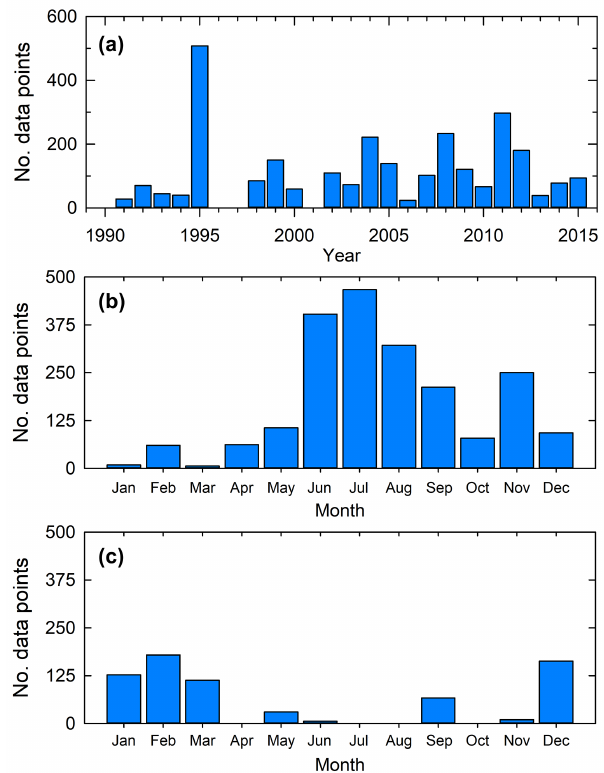
Figure 2. Frequency of CaCO 3 production data by (a) year of mea- surement, (b) month of measurement in the Northern Hemisphere and (c) month of measurement in the Southern Hemisphere.